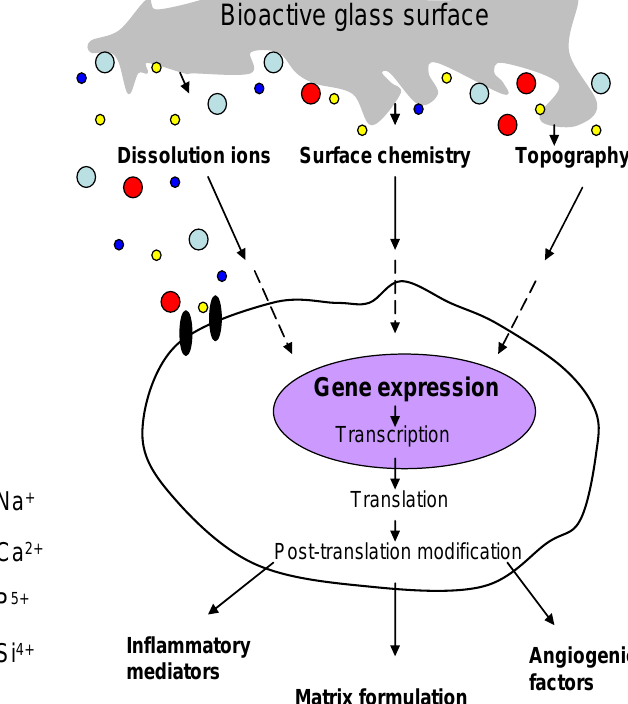
Figure 16. Genetic expression mechanisms in osteoblasts provoked by ion dissolution products of bioactive glasses (adapted from reference